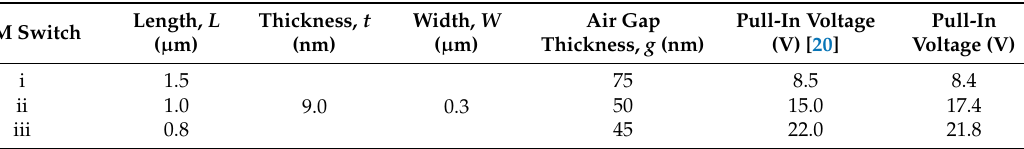
Figure 1. Graphene-based nanoelectromechanical (NEM) switch with bottom actuation electrode: ( a ) schematic diagram; ( b ) side view. Table 1. Dimensions of the intact graphene beam NEM switch.